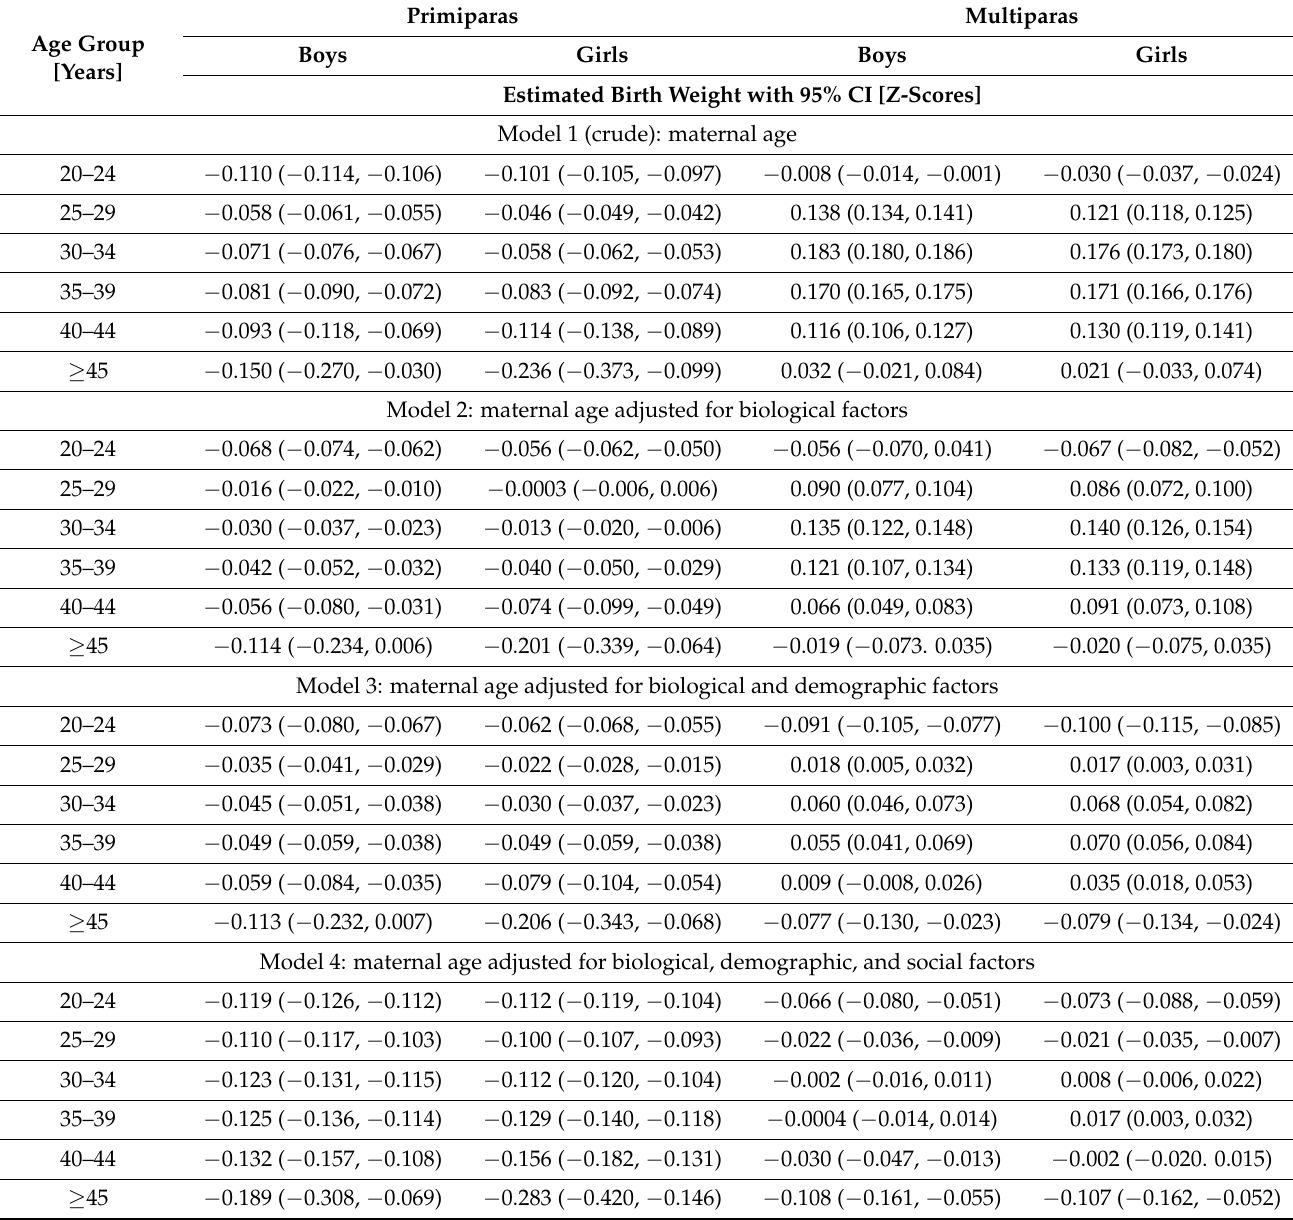
Table 4. Birth weight Z-scores estimated in relation to maternal age groups, stratified by parity and sex of